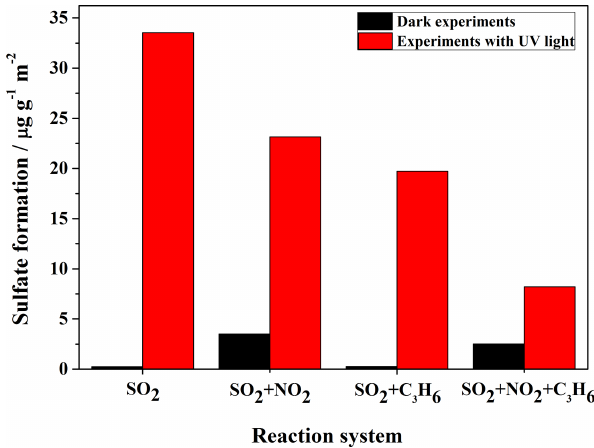
Figure 3. Ion chromatography results of the amounts of sulfate (product per unit mass divided by surface area of sample) formed on the surface of TiO 2 after reaction with SO 2 , SO 2 + NO 2 , SO 2 + C 3 H 6 , and SO 2 + C 3 H 6 + NO 2 in experiments under dark conditions or with UV–Vis light. Since formaldehyde was added to inhibit the oxidation of sulfite to sulfate in the solution, there is a possibility that HMS would be generated in the solution and would be mea- sured as